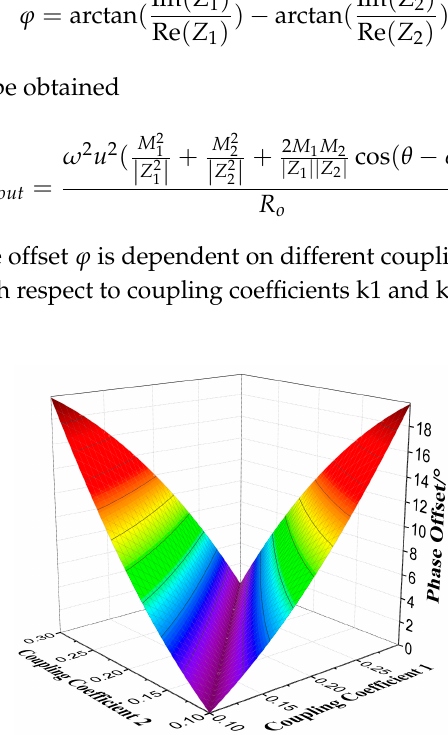
Figure 5. Flow chart of power regulation by phase-shift. It should be noted that prior knowledge of k1 and k2 should be obtained before phase-shift regulation. There are a few online identification methods ([18,19]) which can be utilized in the practice. 5. Analysis of System Output Under Parameters Variation 5.1. Influence of Load Variation on System Figure 6 shows the comparison of the output power and efficiency in the case of load changes. The red line represents the DEU-WPT system, the blue line represents the general WPT system, and the green line represents the improving times of output power of DEU-WPT system compared to